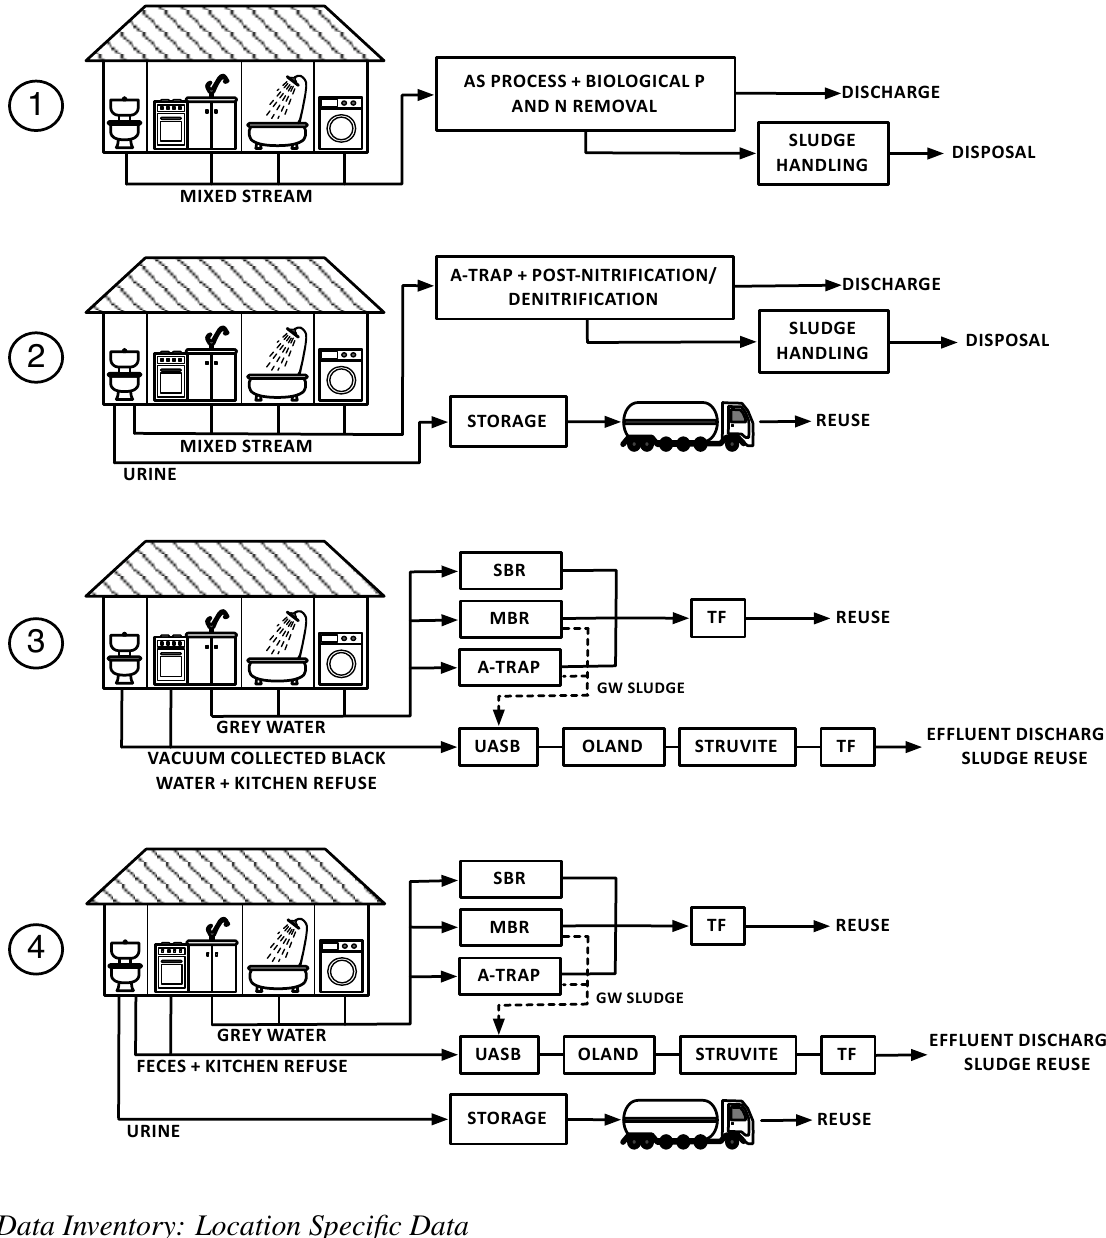
Figure 1. Sanitation Concepts ( 1 – 4 ) included in the model with wastewater streams and corresponding treatment systems (AS = activated sludge process; SBR = sequencing batch reactor, MBR = membrane bioreactor; A-trap = A-stage of AB-process; TF = trickling filter; UASB = up-flow anaerobic sludge blanket reactor; OLAND = oxygen limited anaerobic nitrification